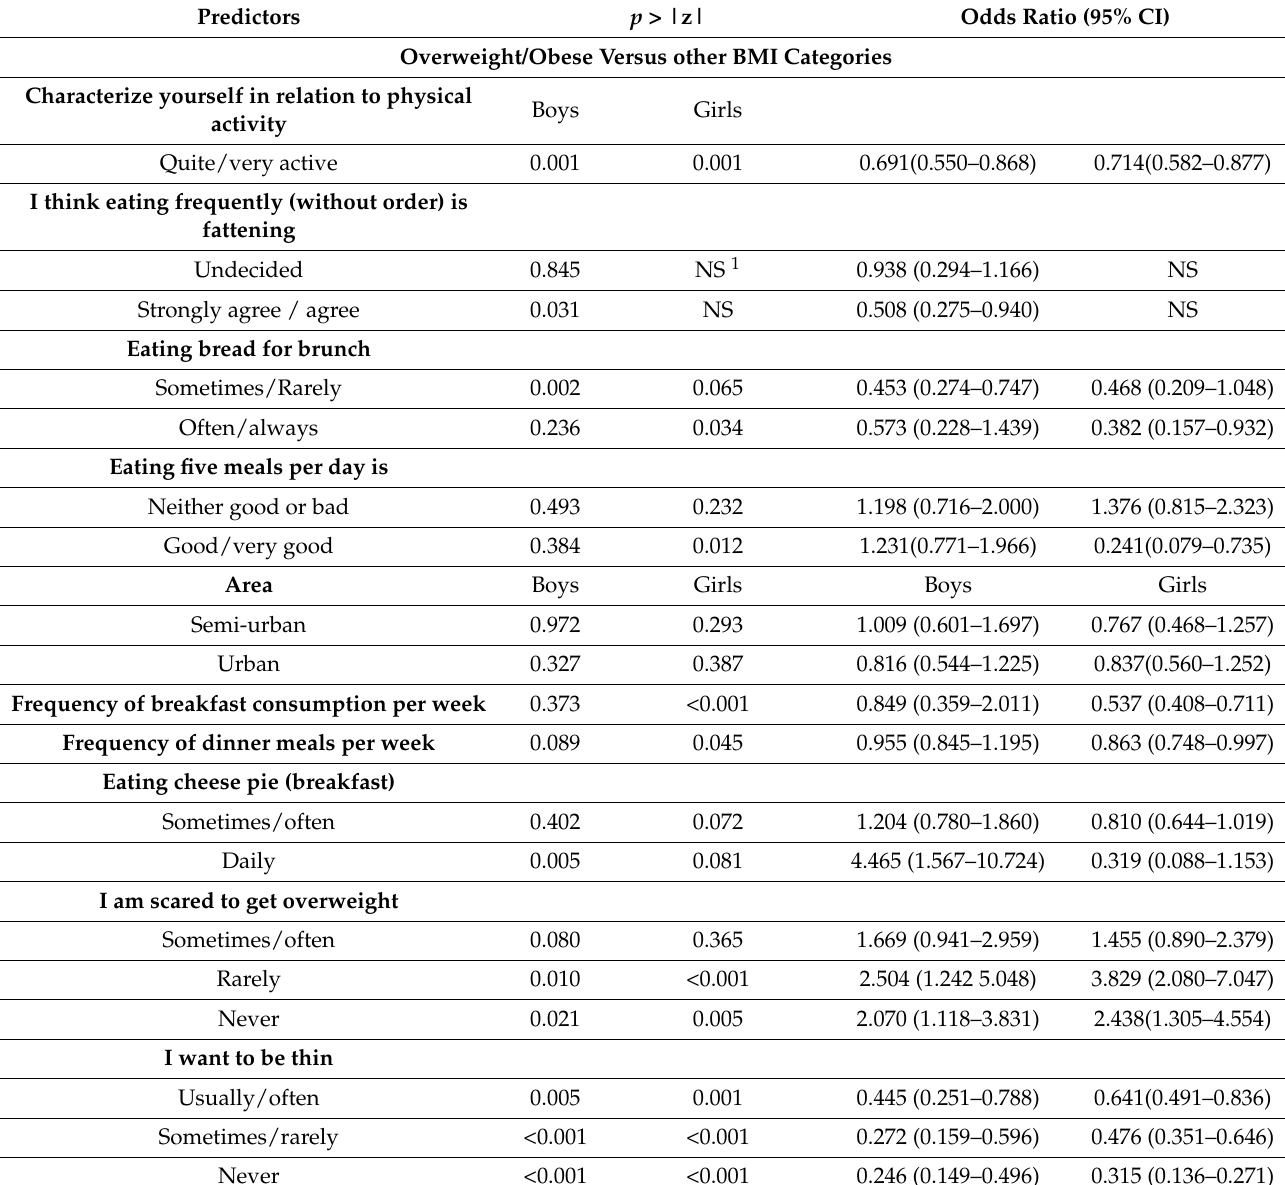
Table A6. Maximum likelihood estimates of Partial proportional odds model (overweight/obese versus other BMI